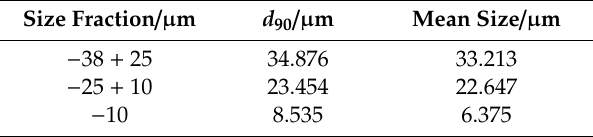
Table 2. The size distribution of narrow size fractions.